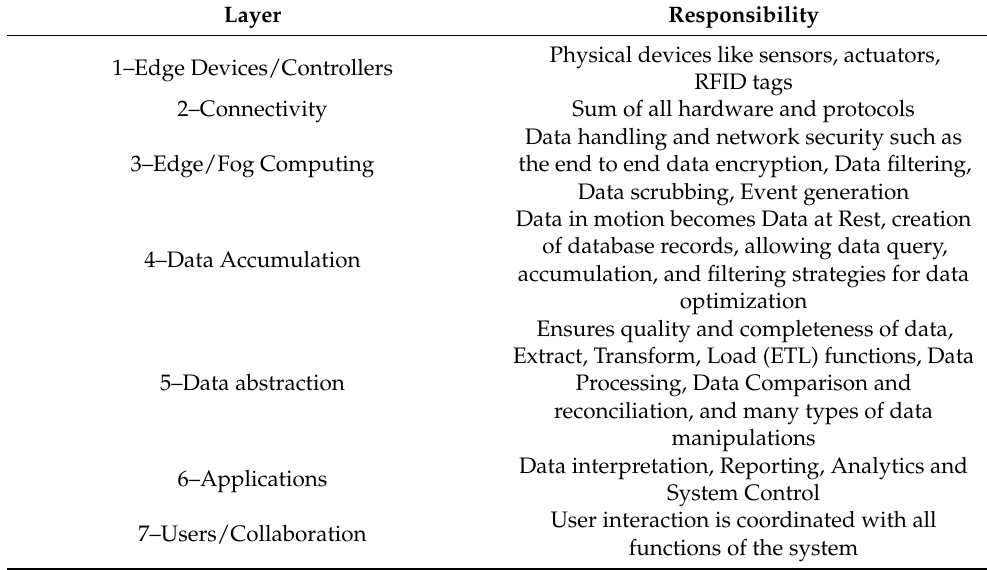
Table 1. Layers and respective responsibilities of the IWF